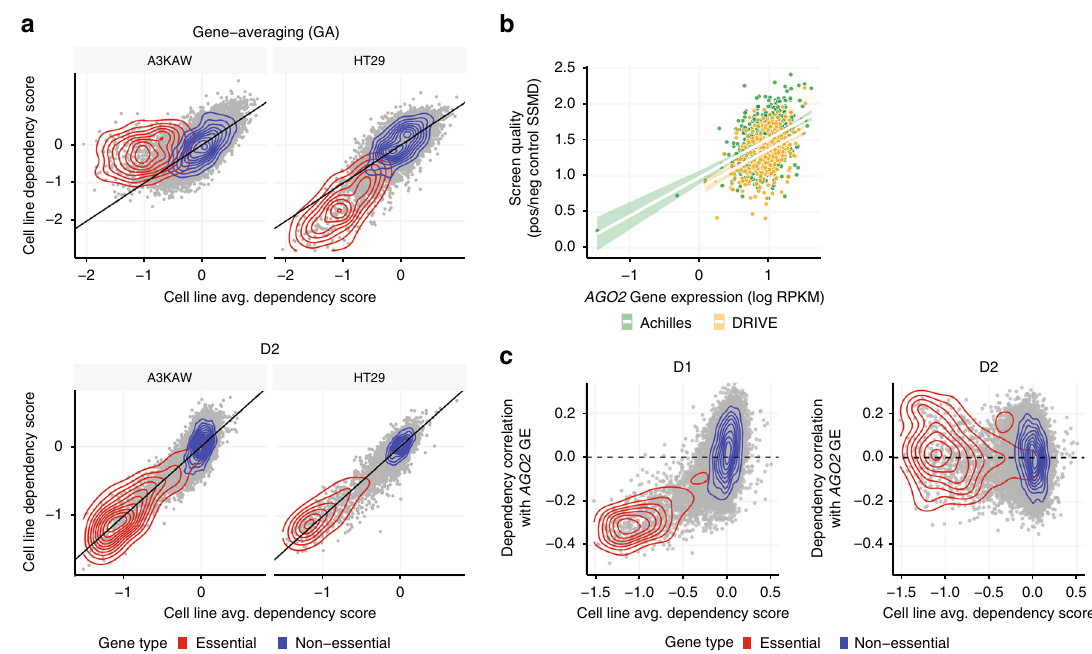
Fig. 2 D2 corrects biases related to variable screen quality. a Comparison of across-cell-line average gene dependency scores with scores estimated for individual example low- (left) and high- (right) quality screens. Density estimates for the set of gold-standard common essential and non-essential genes are highlighted by the red and blue contours, respectively. Estimates using gene-averaging (GA; top plots) show broad systematic differences across all essential genes in these cell lines compared with the population average. These systematic differences are corrected for by D2 (bottom plots). b The screen quality estimated for each cell line (SSMD of positive/negative control gene dependencies, using GA) was correlated with the expression level of AGO2 for both the Achilles (Spearman ’ s rho = 0.39; p < 2.2 × 10 − 16 ; green) and DRIVE (rho = 0.37; p = 1.3 × 10 − 13 ; gold) datasets. c Correlation between each gene ’ s dependency pro fi le and mRNA expression of AGO2 is plotted against the across-cell-line average dependency score for the gene, with curated common-essential and non-essential genes indicated with red and blue dots, respectively. Using D1 (left), gene dependency pro fi les were systematically (negatively) correlated with the AGO2 expression for more common essential genes. This correlation was eliminated using D2